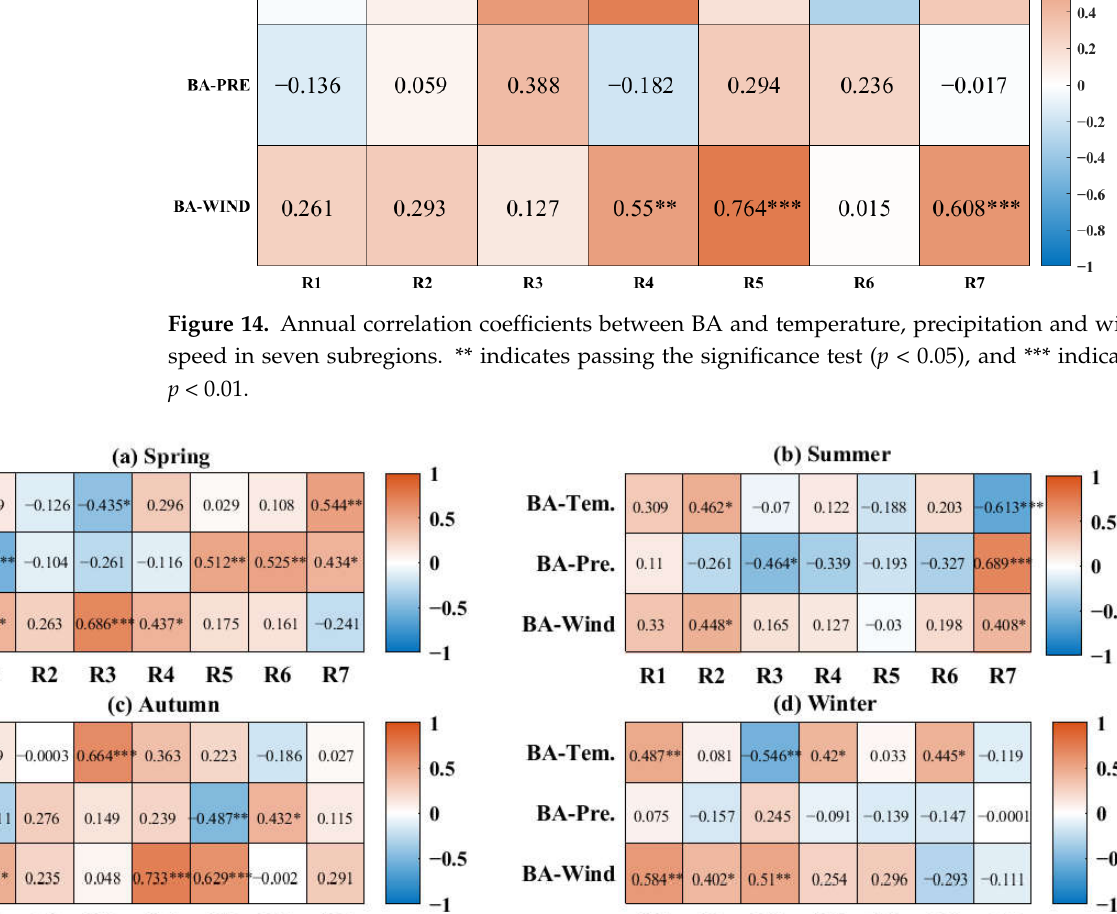
Figure 15. Correlation coefficients between BA and three climatic factors in seven subregions in four seasons: ( a ) spring; ( b ) summer; ( c ) autumn and ( d ) winter. * indicates passing the significance test ( p < 0.1), ** indicates p < 0.05, and *** indicates p <